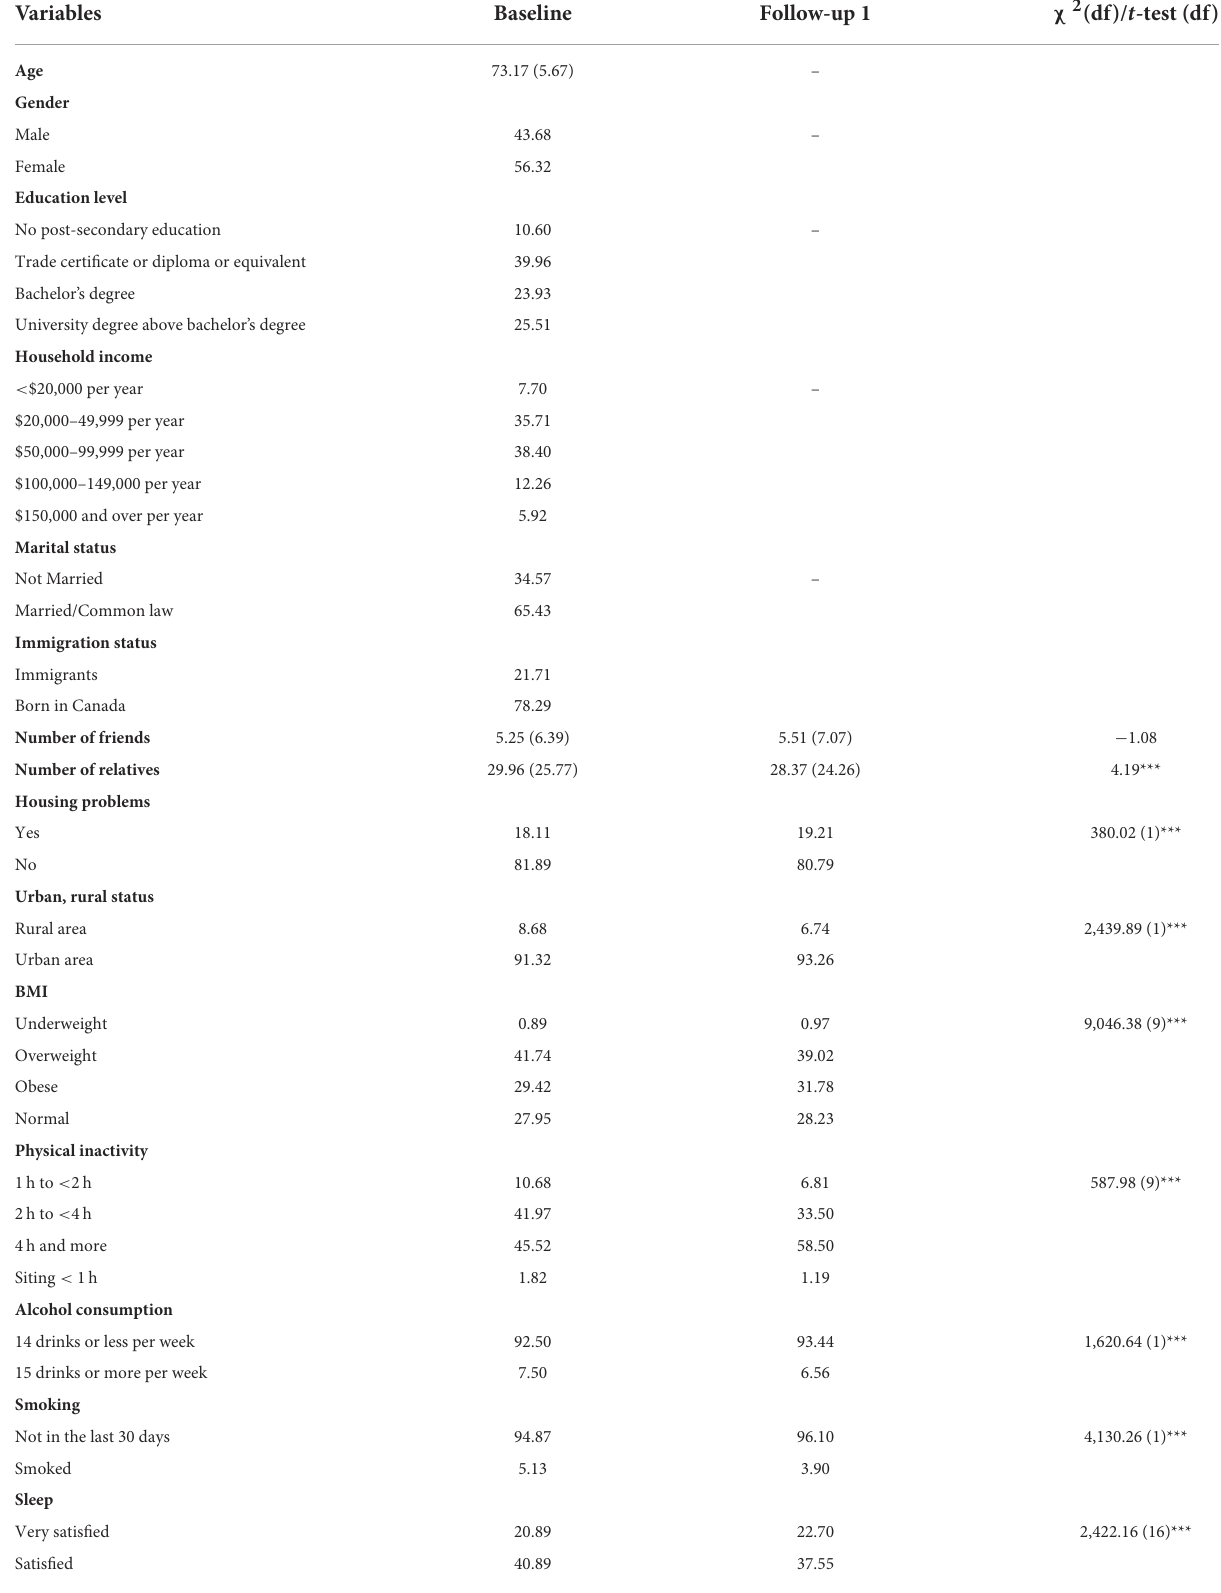
TABLE 1 Socio-demographic, social and environmental, behavioral and lifestyle, and health contextual information among participants. Variables